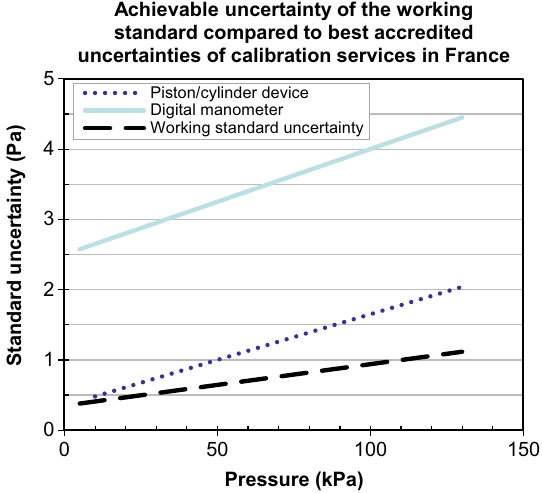
Fig. 10. Final uncertainty of the working standard together with the best accredited uncertainties of calibration services in France and the corresponding apparatus